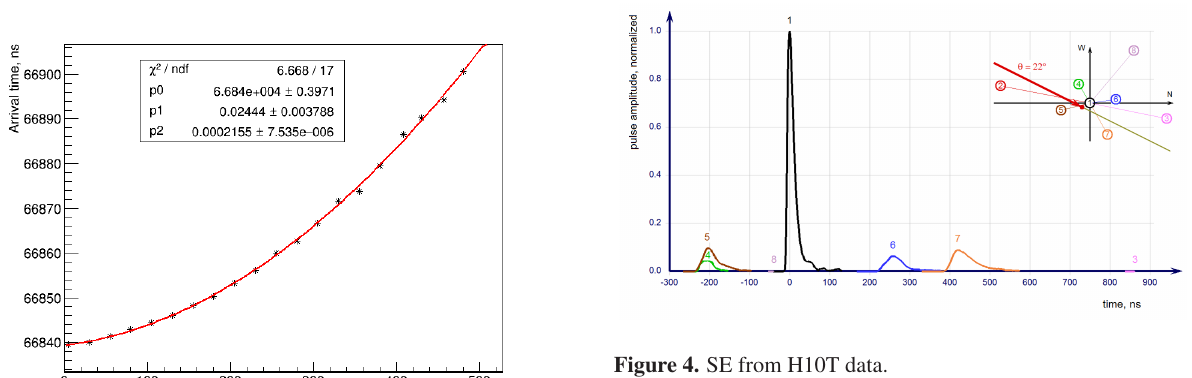
Figure 4. SE from H10T data.